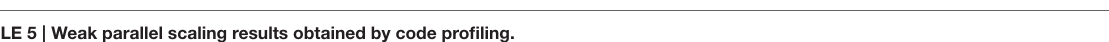
15 ms with standard deviation σ onset 5 ms . = =